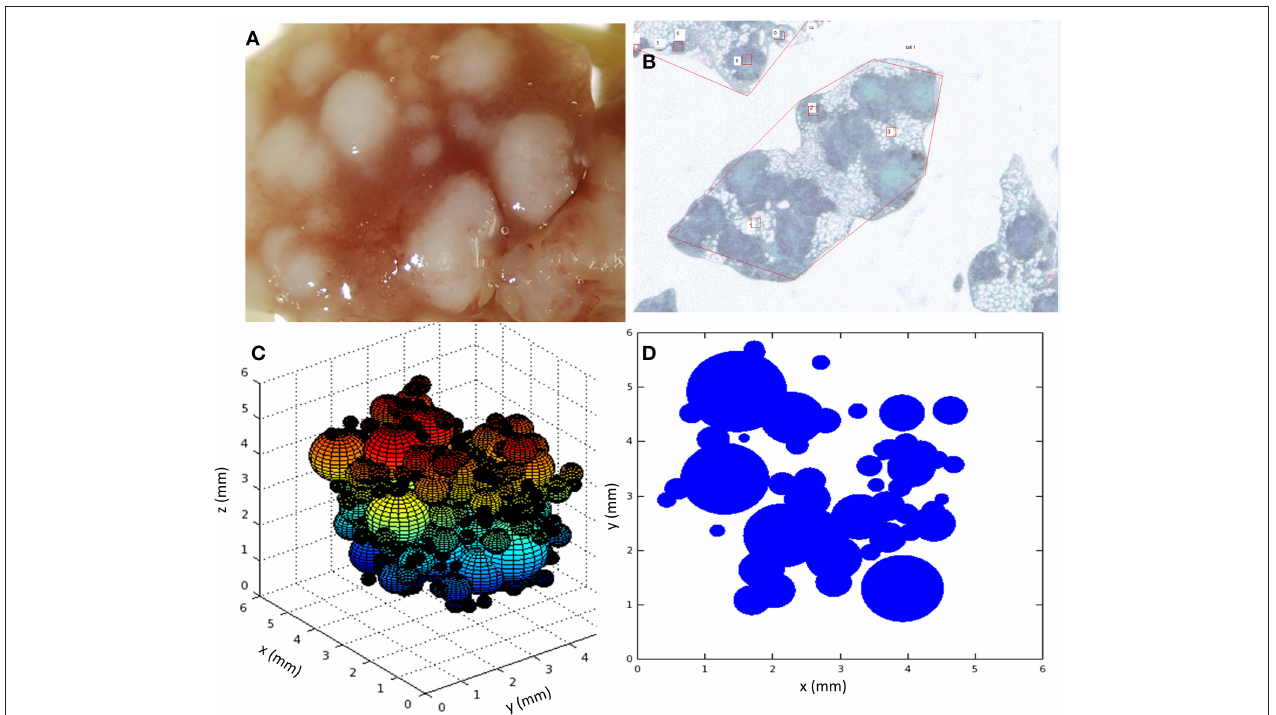
FIGURE 1 | (A) Macroscopic image of the lung at day 30; (B) Microscopic image of paraffined slides of infected mice lungs; (C) snapshot of a 3D view of the simulation system, each sphere representing a lesion; (D) snapshot of a 2D slide of the simulation system, each circle representing a slide of a lesion. Simulations used parameters of panel B ( Table 1